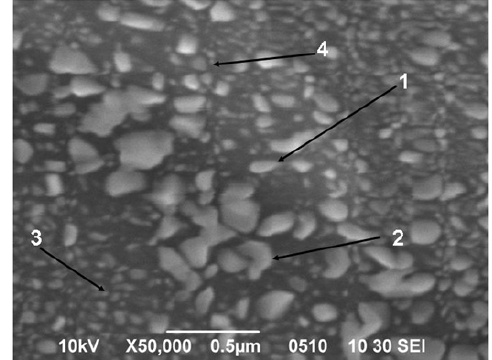
Figure 4. Pore size distribution of samples TiO (C) 680 o C; (A) 830 o C.